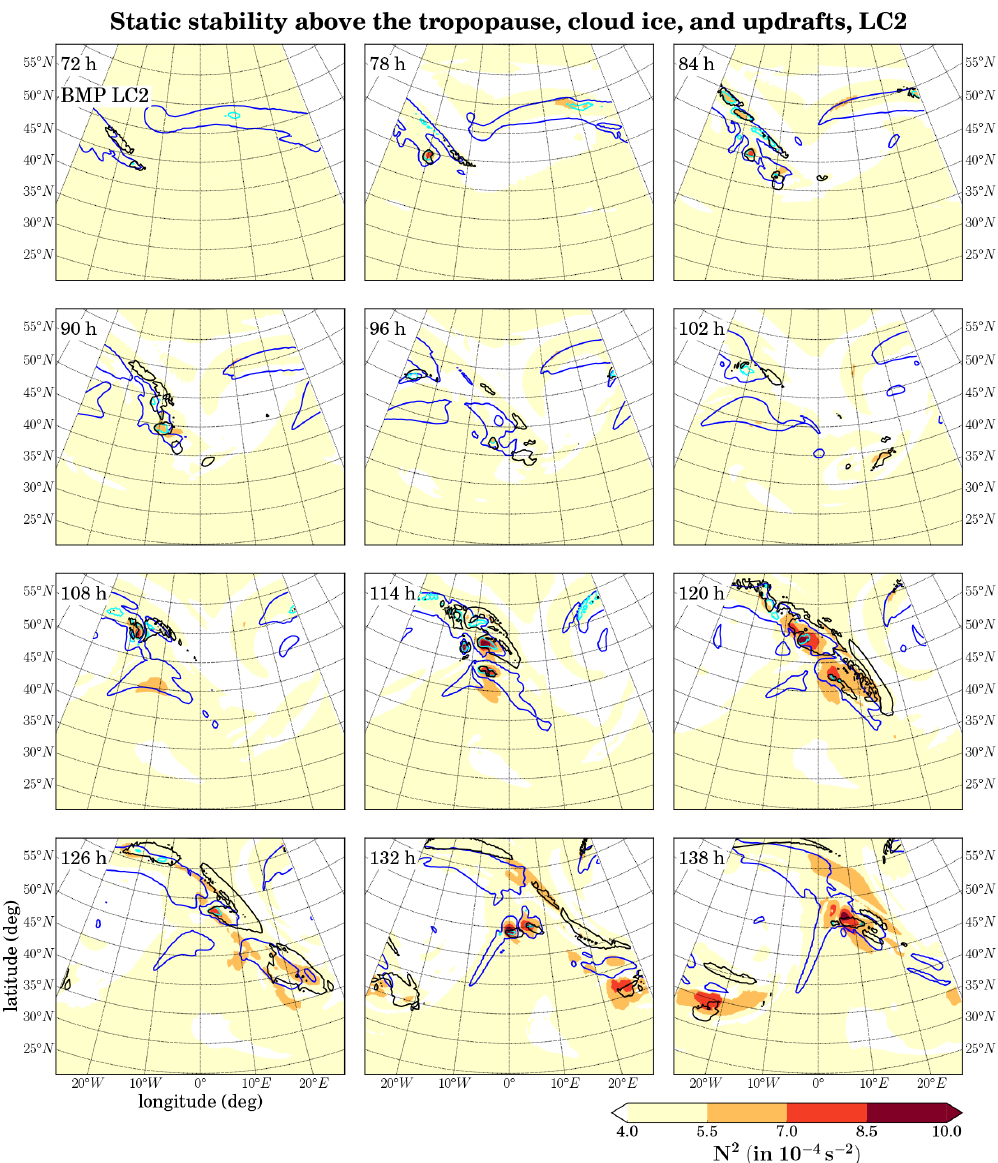
Figure 16. As Fig. 9, but for BMP